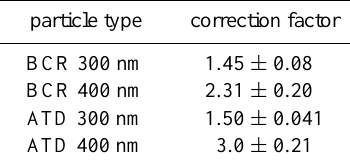
Table A2. Transmission correction factors: The errors have been estimated by varying the mode diameter and the geometric width in the range of the fitting parameter